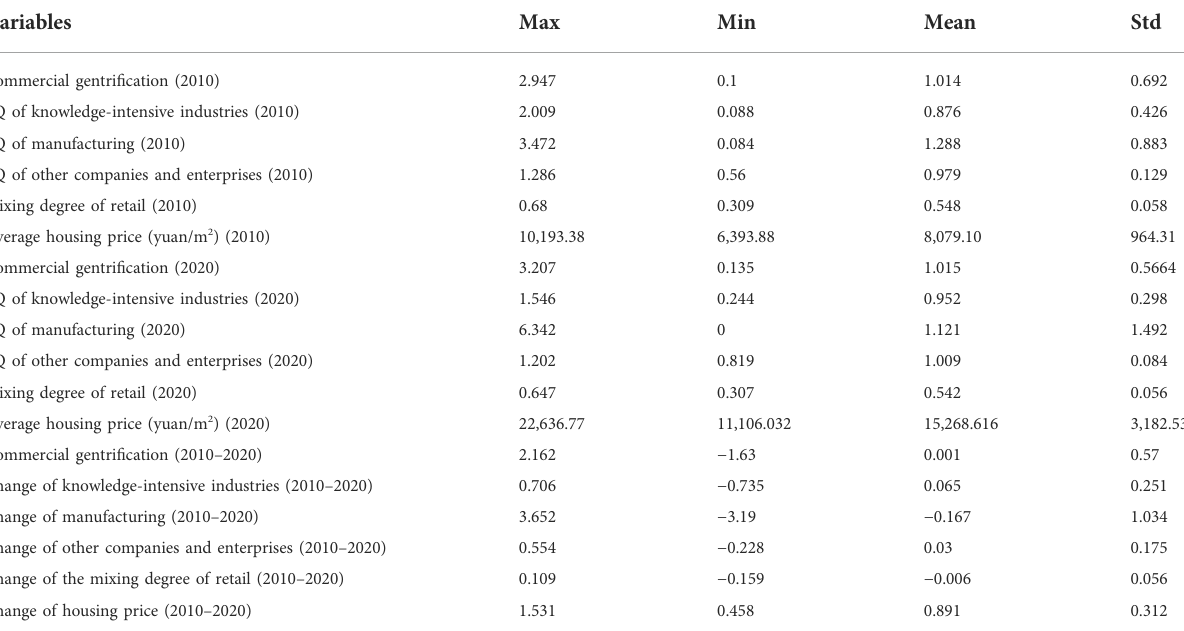
TABLE 5 Descriptive analysis of